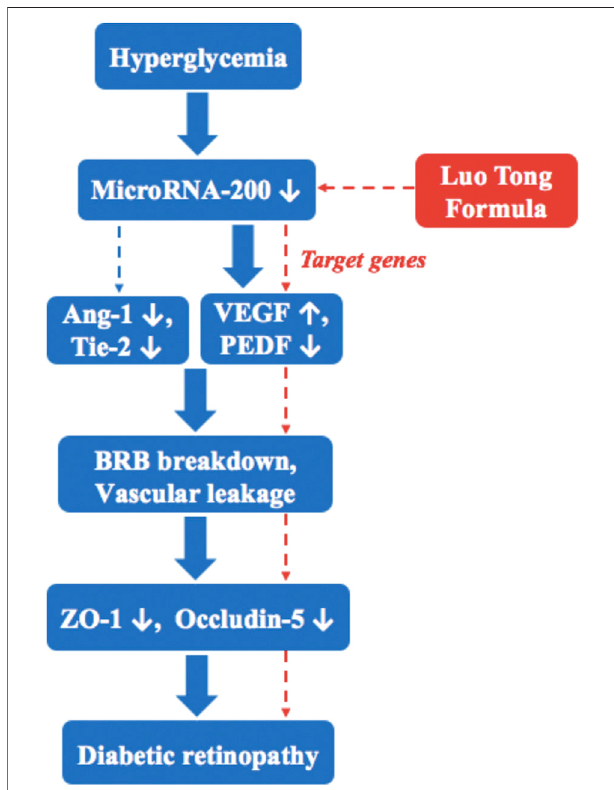
FIGURE 9 | The miR-200b/VEGF pathway is involved in DR, which is inhibited by LTF.